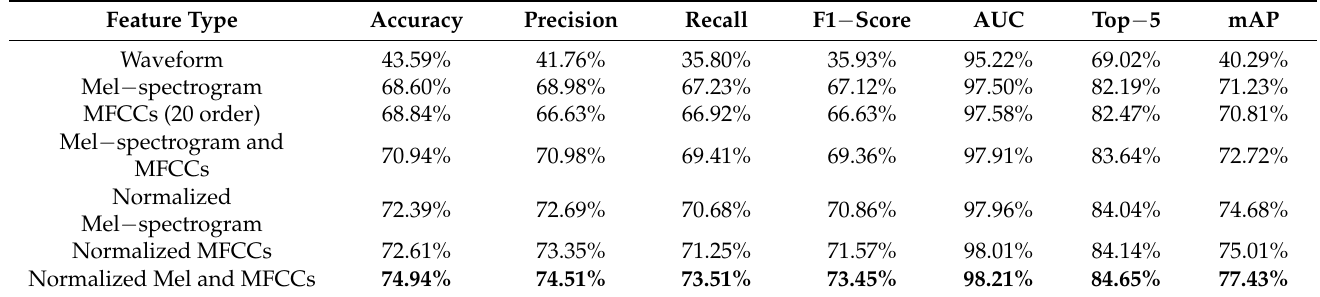
Figure 9. Boxplots of the proposed model. Each metric includes 264 results. Statistics: Pre max = 100.00%, Pre min = 40.02%, Pre std = 0.1170, Pre avg = 74.51%; Rec max = 100.00%, Rec min = 30.76%, Rec std = 0.1268, Rec avg = 73.51%; F1 max =100.00%, F1 min = 34.78%, F1 std = 0.1090, F1 avg = 73.45%; AUC max = 100.00%, AUC min = 88.29%, AUC std = 0.0163, AUC avg = 98.21%; mAP max = 100.00%, mAP min = 36.25%, mAP std = 0.1195, mAP avg = 77.43%.